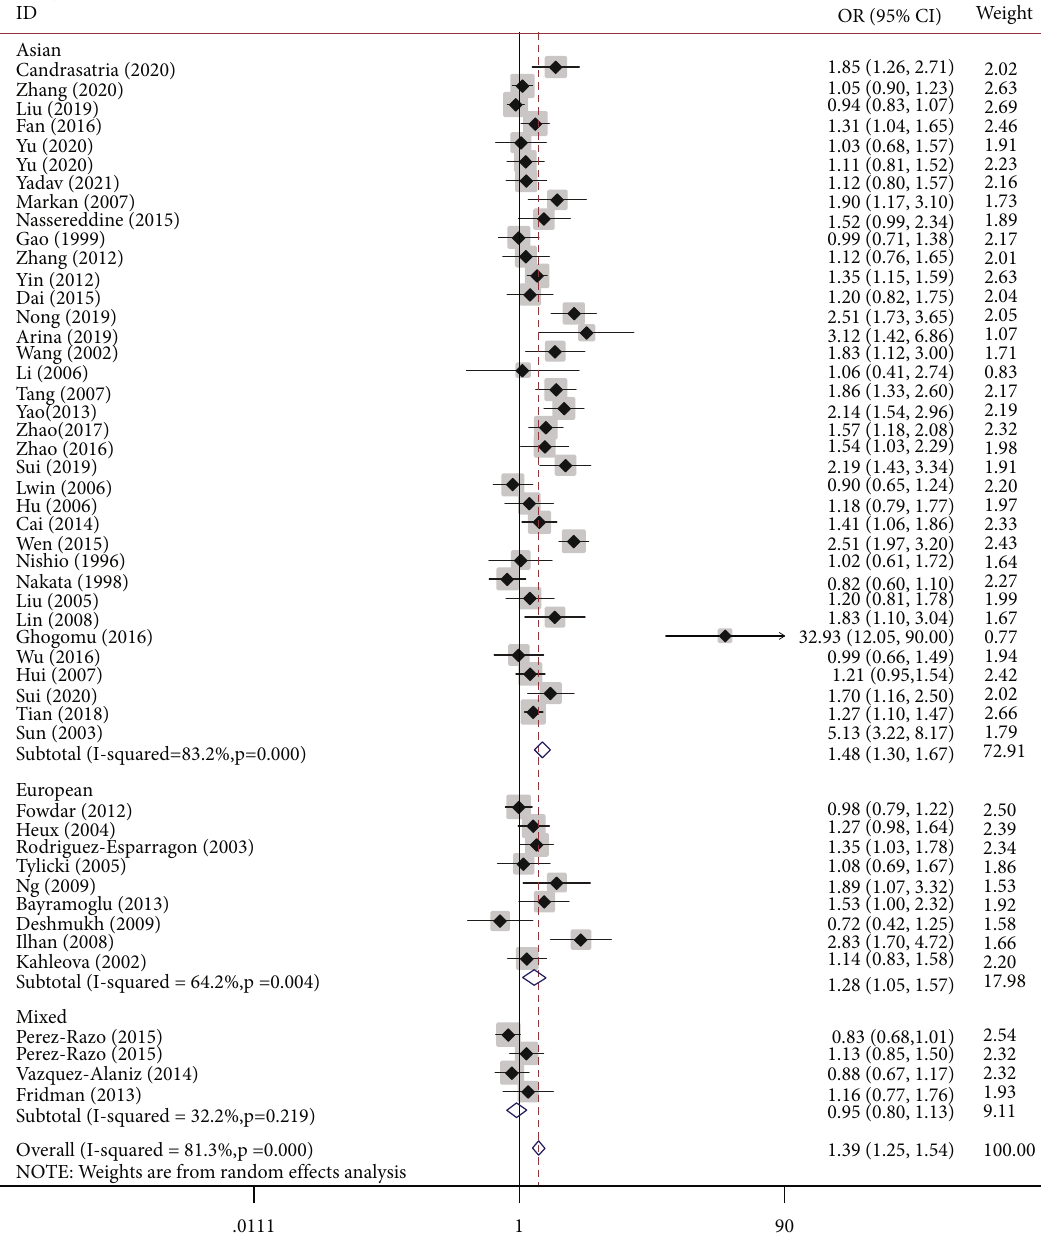
Figure 4: T-allele frequencies for the MTHFR gene rs1801133 polymorphism among cases/controls strati fi ed by subgroups in T-allele vs. C- allele model in regular ethnic